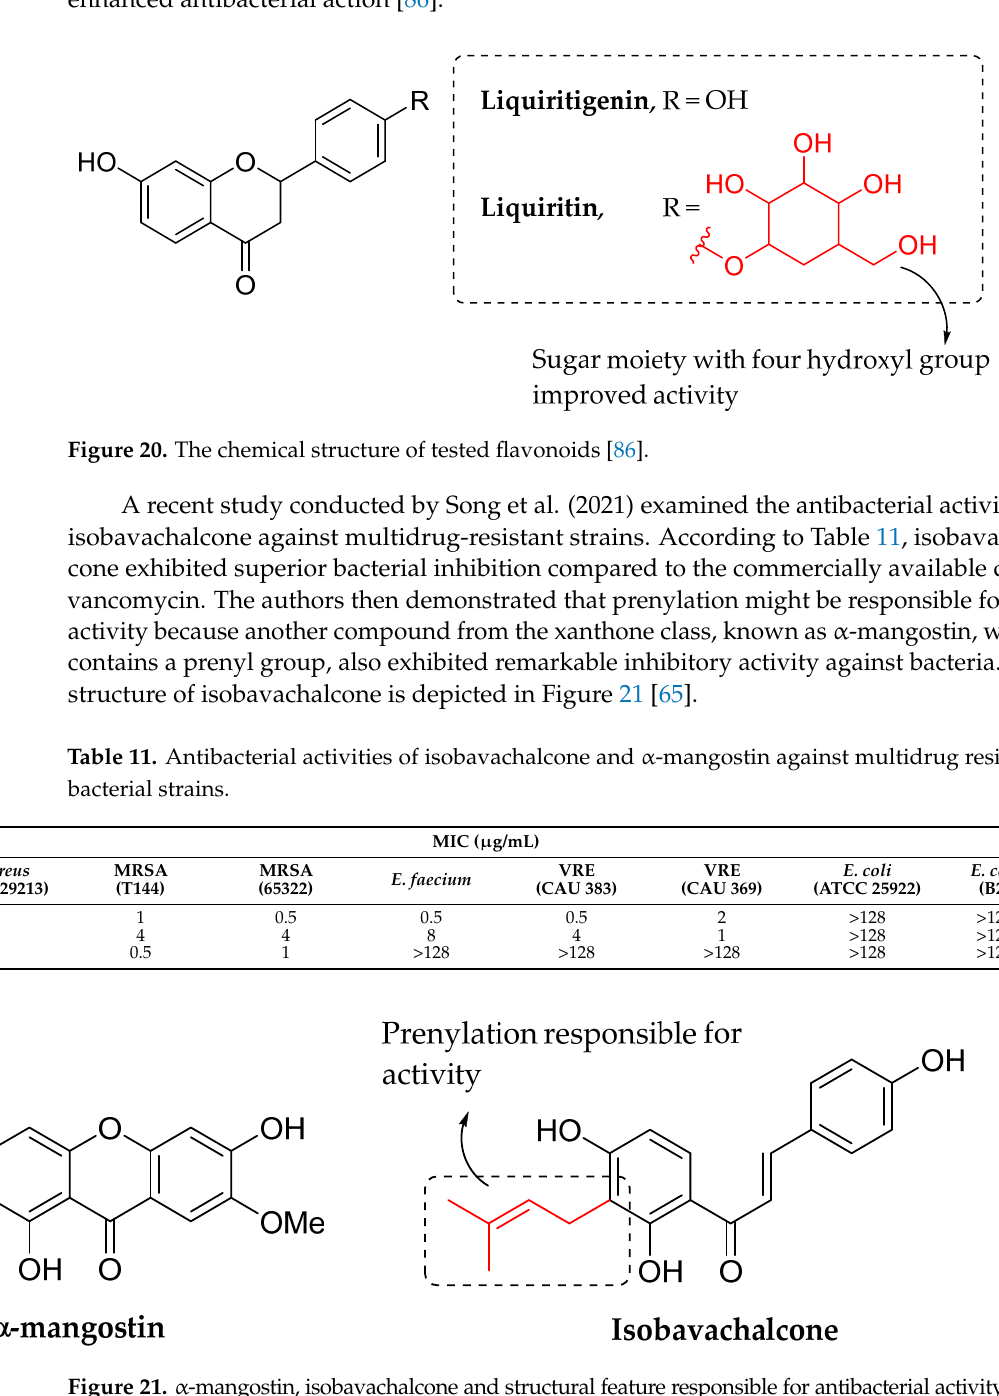
Figure 20. The chemical structure of tested flavonoids [86].